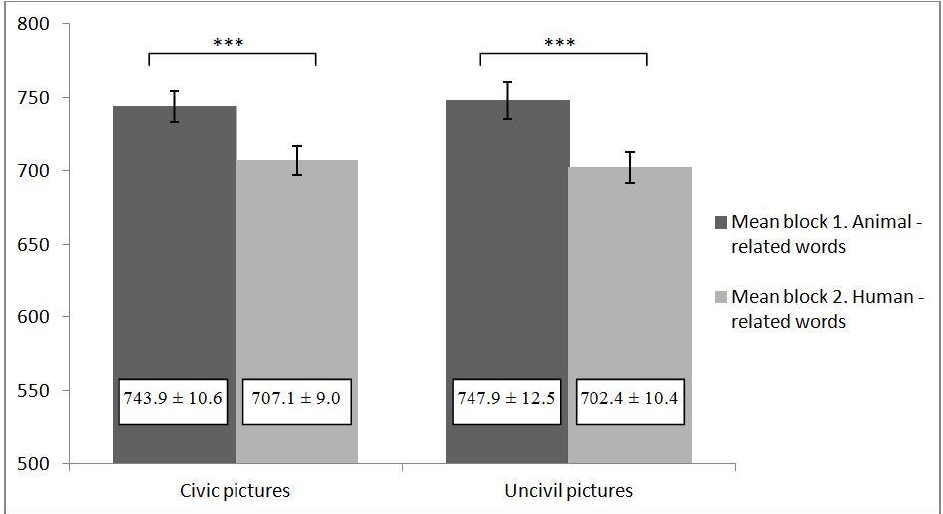
Figure 3. Means ± standard error for reaction times (in milliseconds) of blocks 1 and 2 in the study. *** indicated p < 0.001.